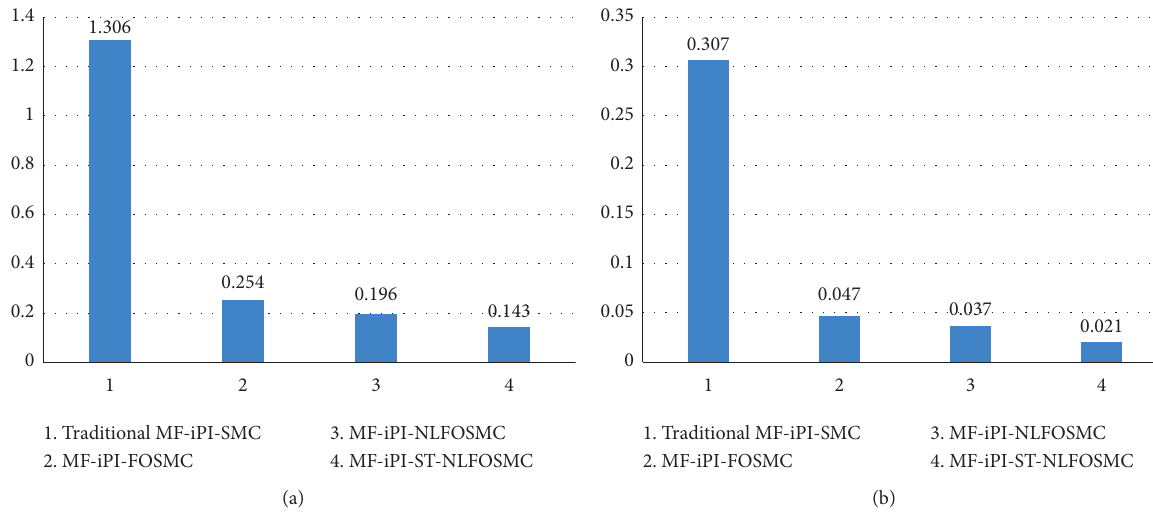
Figure 7: (a) Maximum absolute errors under the traditional MF-iPI-SMC, the MF-iPI-FOSMC, the MF-iPI-NLFOSMC, and the MF-iPI- ST-NLFOSMC with load. (b) Root-mean-square errors under the traditional MF-iPI-SMC, the MF-iPI-FOSMC, the MF-iPI-NLFOSMC, and the MF-iPI-ST-NLFOSMC with load.